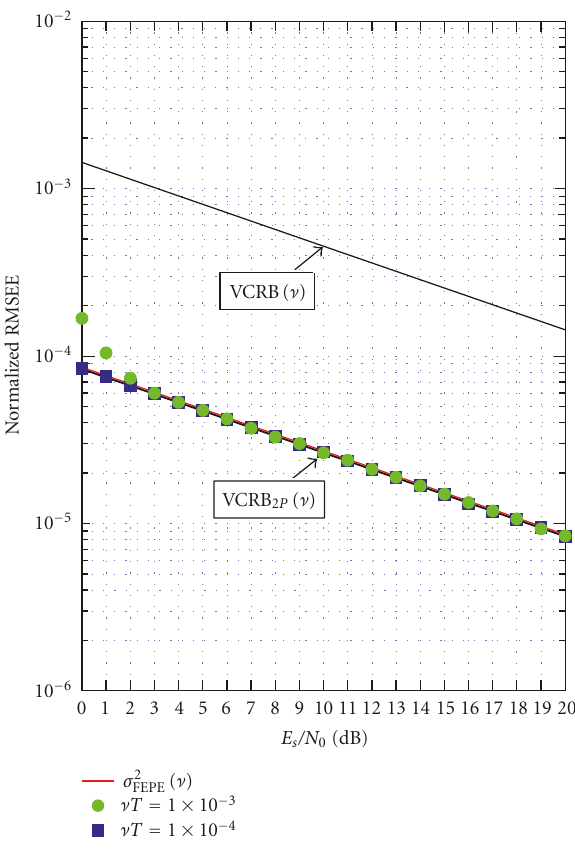
Figure 3: RMSEE of FEPE estimator for di ff erent values of /N E S 0 and relevant bounds—solid lines: theory—marks: simula- tion. Preamble + postamble DA ML phase estimation, N = 44, M =